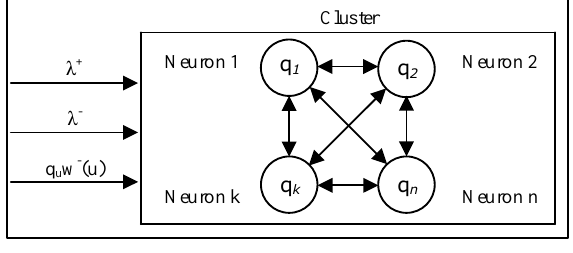
Figure 3. Cluster of Neurons.